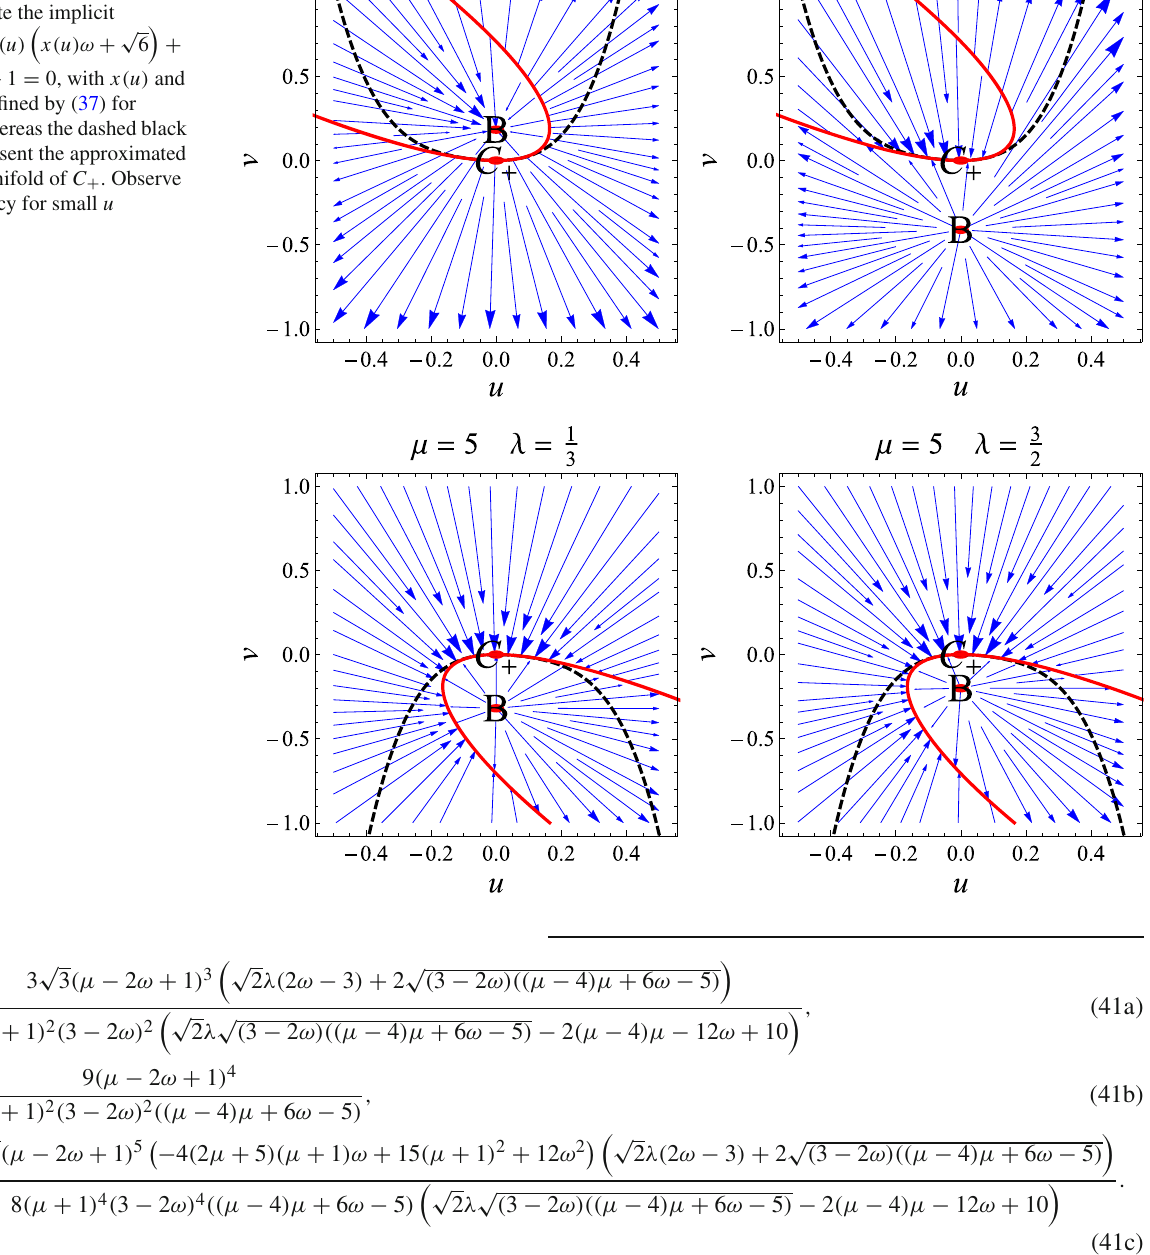
Fig. 3 Qualitative evolution in the phase plane ( u ,v) given by (38) for ω = 1. The solid red lines denote the implicit (cid:9) (cid:10) √ + x ( u )ω + function x ( u ) 6 y ( u ,v) 2 + 1 = 0, with x ( u ) and y ( u ,v) defined by (37) for ω = 1, whereas the dashed black lines represent the approximated center manifold of C + . Observe the accuracy for small u